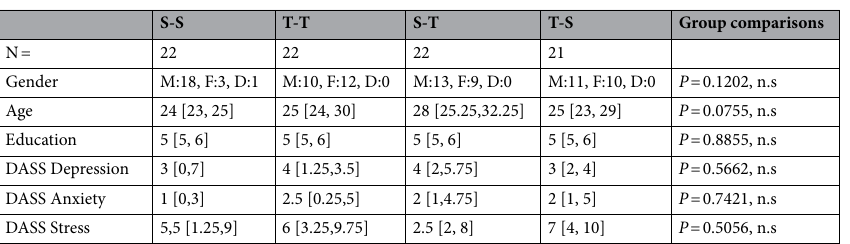
Table 1. Demographic characteristics of randomized assignment of participants to control and experimental groups. No significant group differences were observed with respect to the parameters listed below. P-Values given refer to Kruskal–Wallis statistics. Abbreviations: (S-S: Safety-Safety condition; T-T: Threat-Threat condition; S-T: Safety-Threat condition, T-S: Threat-Safety condition. Values listed refer to medians and interquartile ranges; N = Sample size; M = Male, F = Female, D = Divers; Education = Highest graduation or academic degree: Lowest = 1:No graduation, Highest: 8: Doctorate degree; DASS: Depression Anxiety Stress Scales; n.s. = not